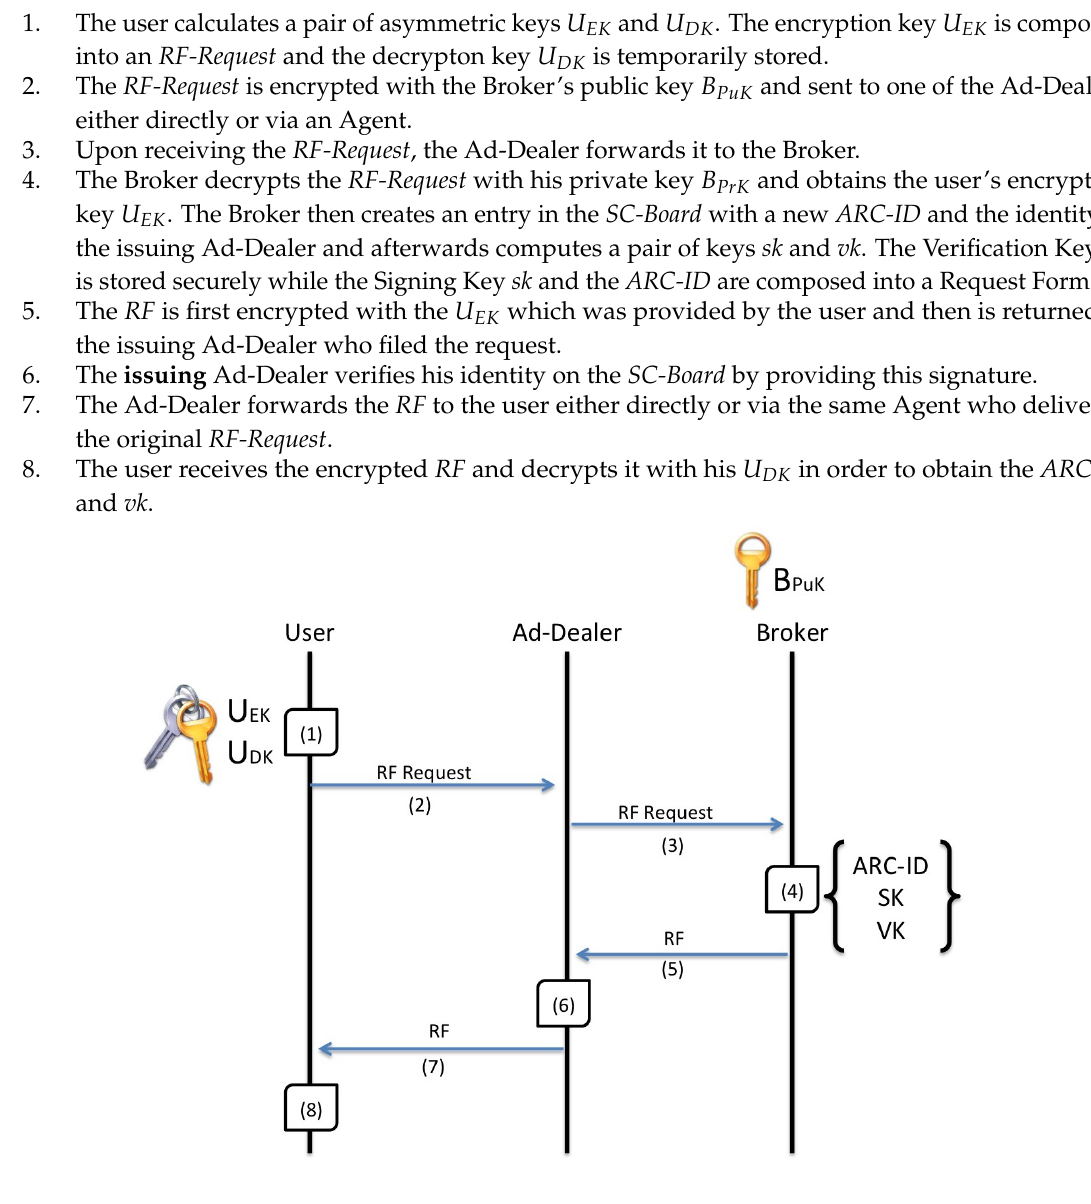
Figure 10. Report Form Collection